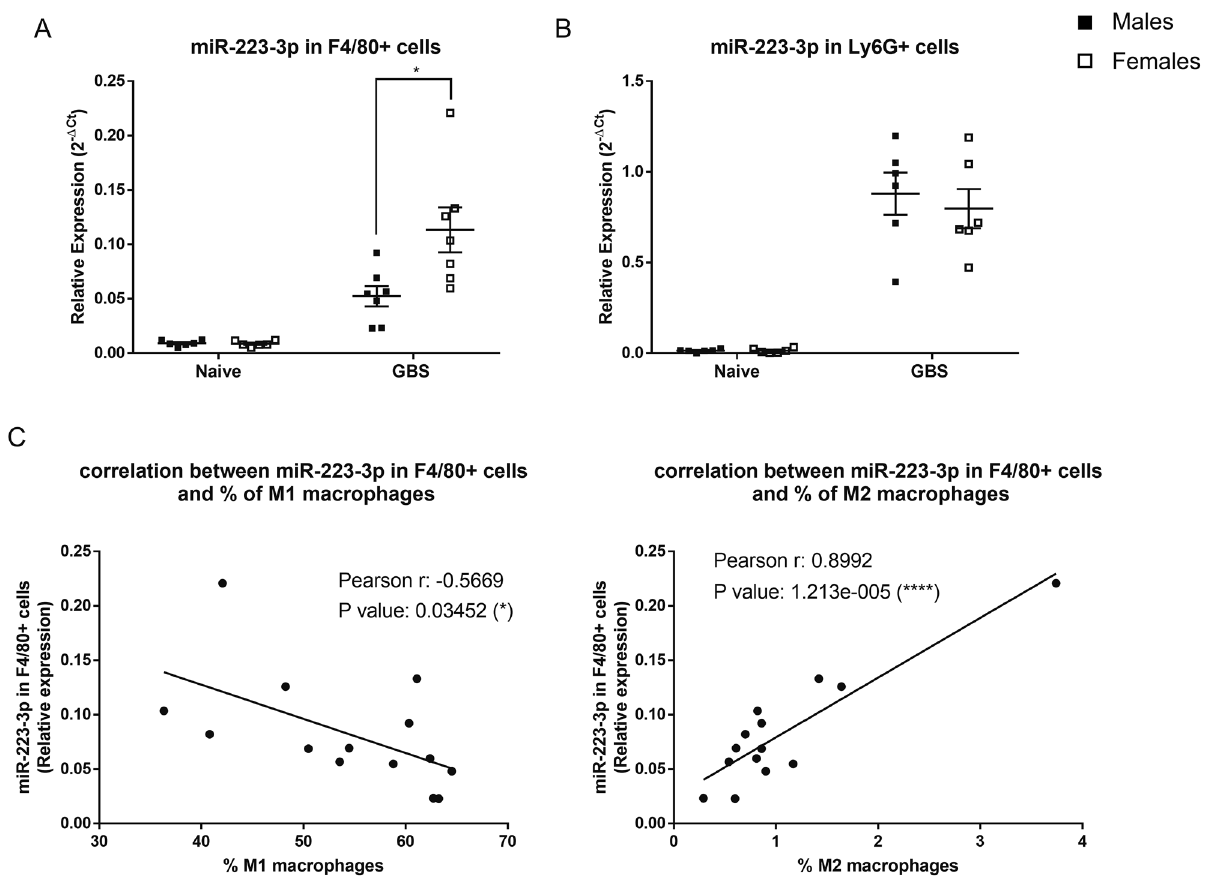
Figure 7. Sex difference in relative miR-223-3p expression in F4/80+ and Ly6G+ cells at 24 h post GBS lung infection. F4/80+ cells and Ly6G+ cells were purified from the lungs of GBS-infected or naive male and female mice (n = 6/group) using F4/80 and Ly6G immunomagnetic antibodies. Comparative analysis of miR-223-3p expression in the F4/80+ ( A ) and in the Ly6G+ ( B ) cell populations was evaluated by real-time qPCR. The values were normalized with two internal controls, snoRNA-202 and snoRNA-234. *p < 0.05 (Mann–Whitney U test). Data are representative of two independent experiments. The percentage of CD80+ and CD206+ macrophages were evaluated by flow cytometry with the gating strategy shown in Fig. S4. Correlation between the miR-223-3p expressed by the F4/80+ cells and the percentage of M1 or M2 macrophages ( C ). *p < 0.05, ****p < 0.0001 (Pearson χ 2